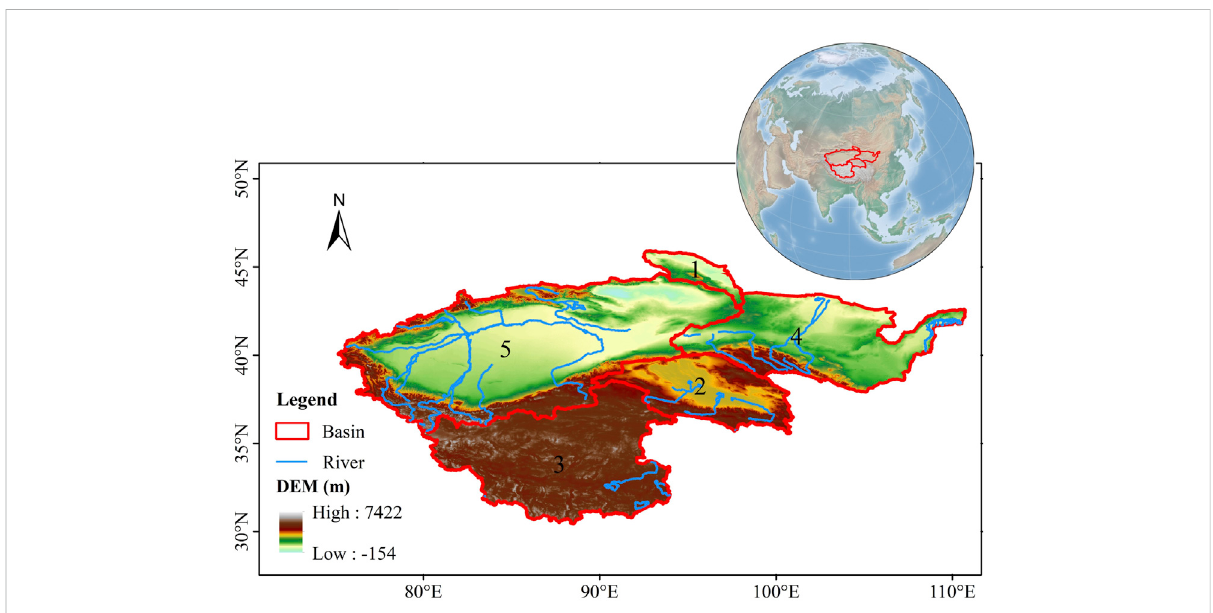
FIGURE 1 Location and distribution of each basin in the Chinese inland basins (CIBs). 1 – 5 represents the Turpan basin (TPB), Qaidam basin (QDB), Qiangtang Plateau basin (QPB), Hexi Corridor basin (HCB), and Tarim basin (TRB),